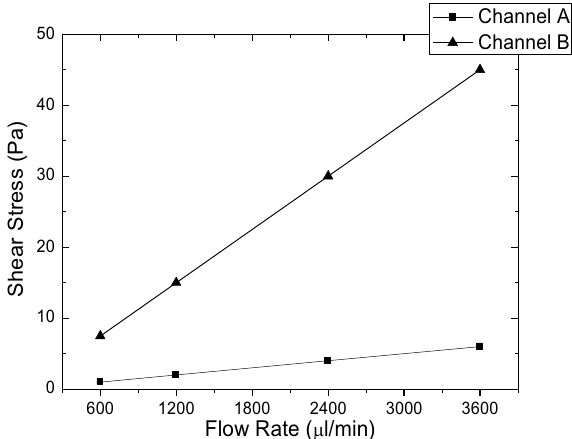
Figure 2. The comparative flow rate-shear stress graphic for microchannel-A and B.